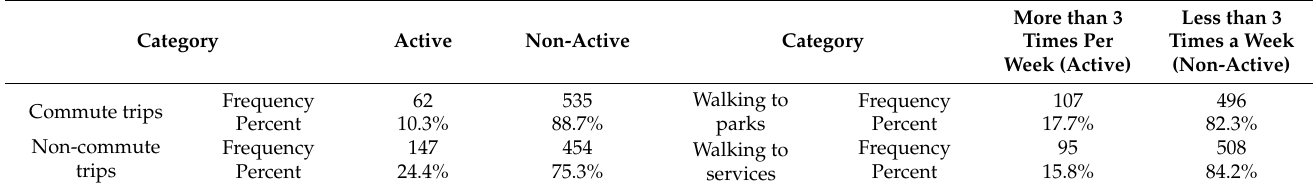
Table 2. Active commute and non-commute trips and frequency of walking to parks and